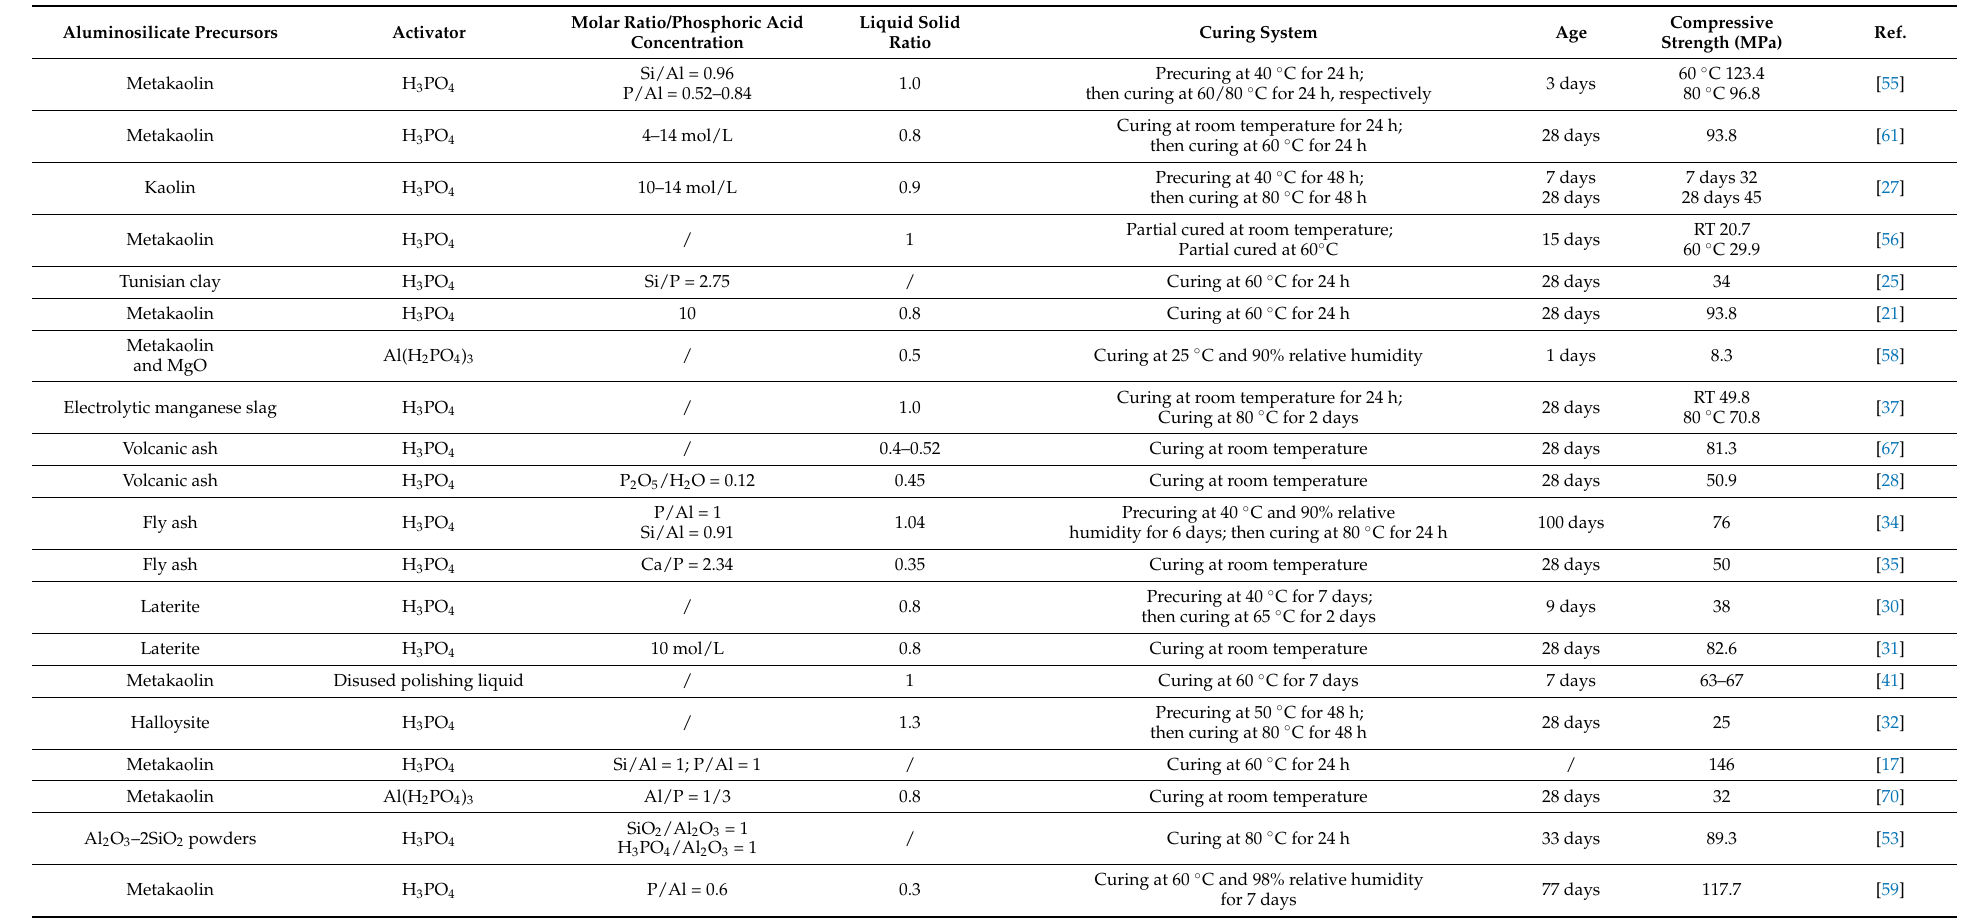
Table 3. Compressive strength database of ASP geopolymers obtained by different synthetic